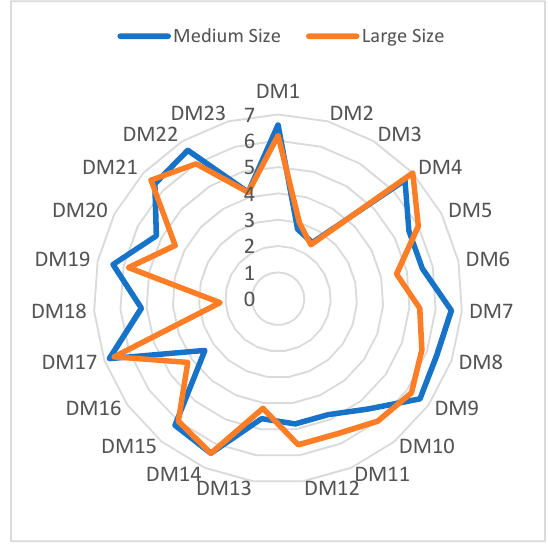
Figure 3. Importance percentage of each impacting factor.